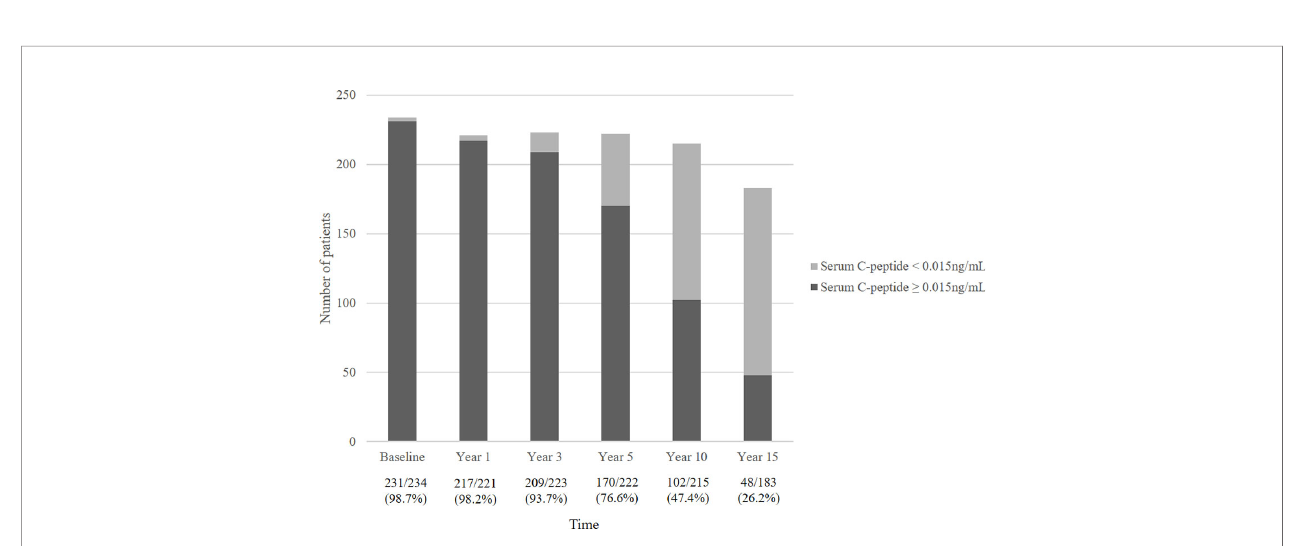
FIGURE 3 | The proportion of patients with residual serum C-peptide